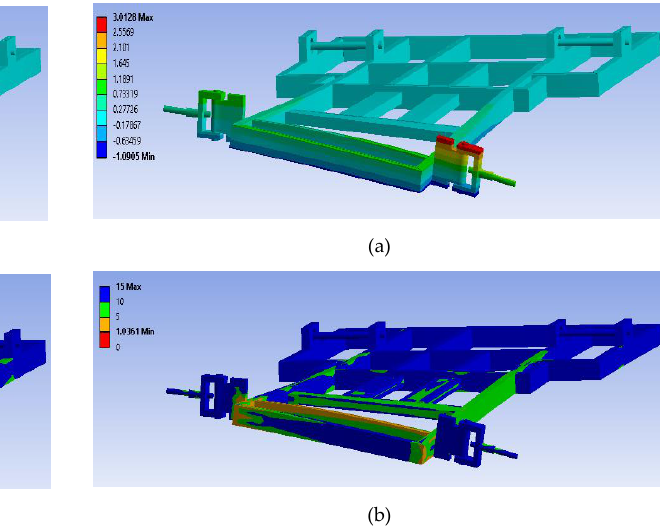
Figure 12: Deformation (a) and safety factor (b) of the first variation chassis simulation